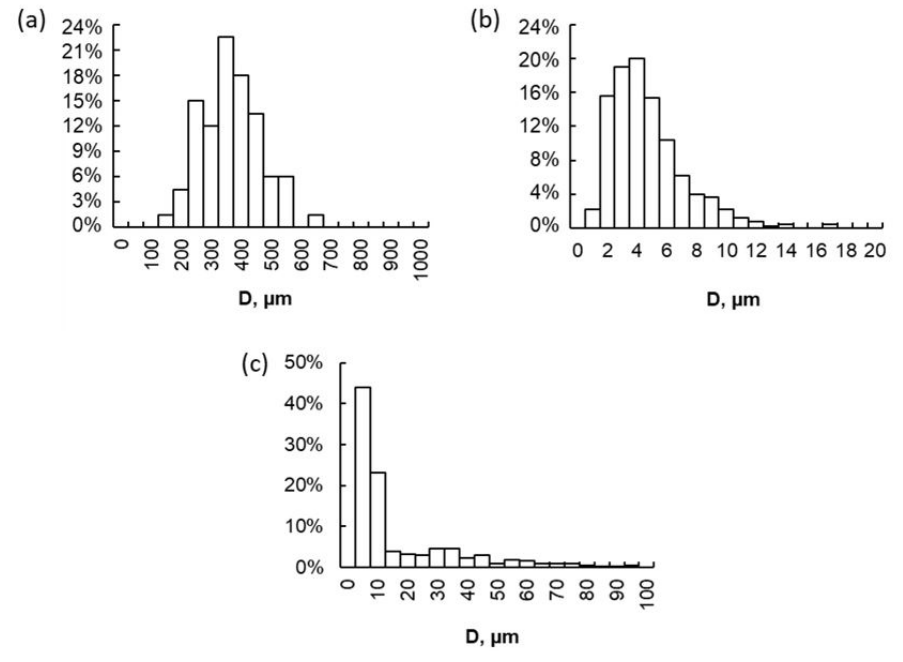
Figure 1. Distribution of particle size of AG Pleisch carbon sorbent before grinding ( a ) and after four hours of grinding in a planetary ball mill, ( b ) and of SAR carbon sorbent after four hours of grinding ( c ).